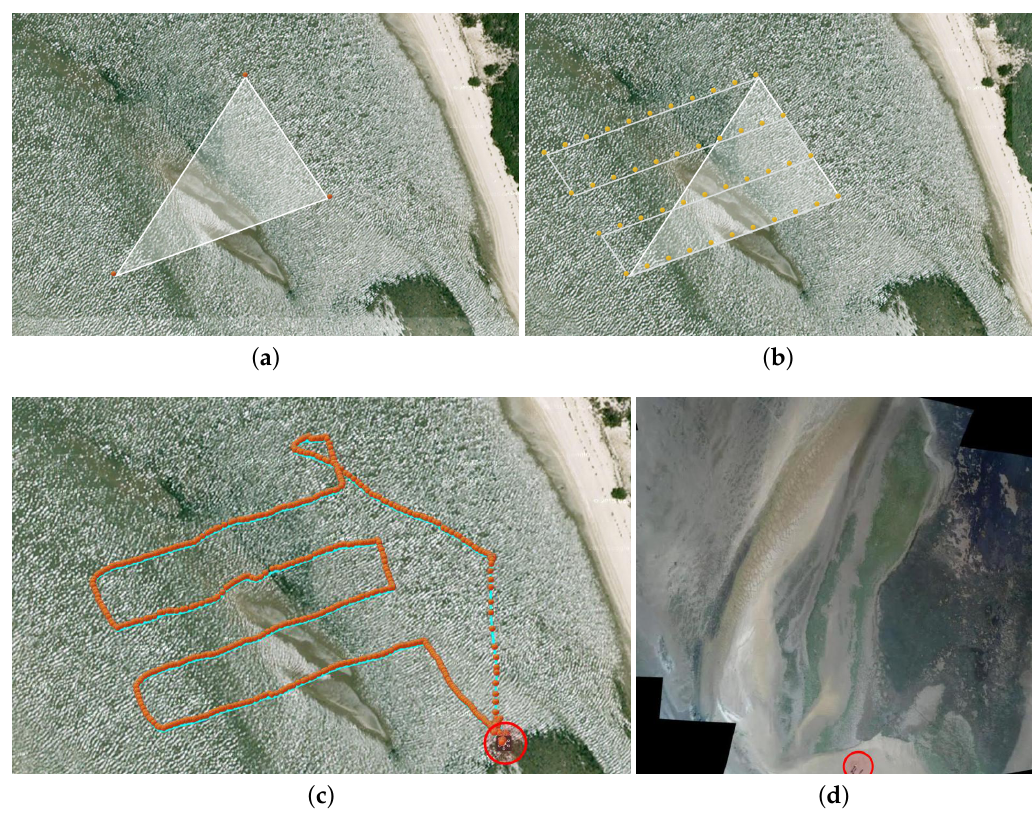
Figure 10. The aerial mosaic creation process. ( a ) The expert defines the survey area by setting three geo-referenced points in the GUI (depicted in orange); ( b ) a set of waypoints (in yellow) is automatically generated so as to ensure that the UAV takes significant key frames for the registration process; ( c ) satellite imagery of the site with the UAV’s executed path overlaid. This path was generated by following several waypoints in sequence. The UAV’s starting spot is depicted by the red circle overlay. ( d ) The resulting aerial panorama with the UAV’s starting point depicted by the red circle